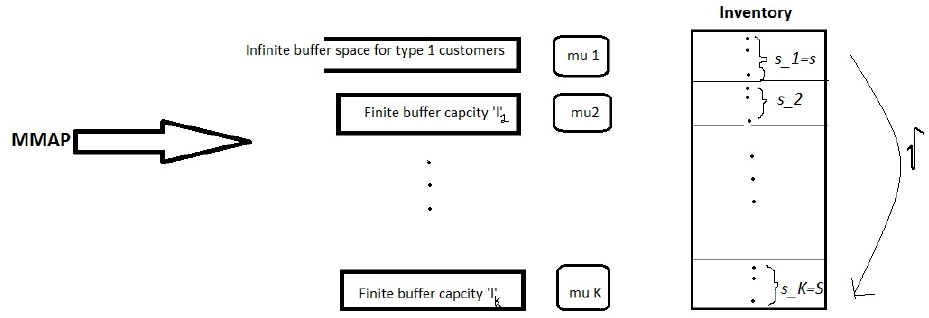
Figure 1. Structure of the